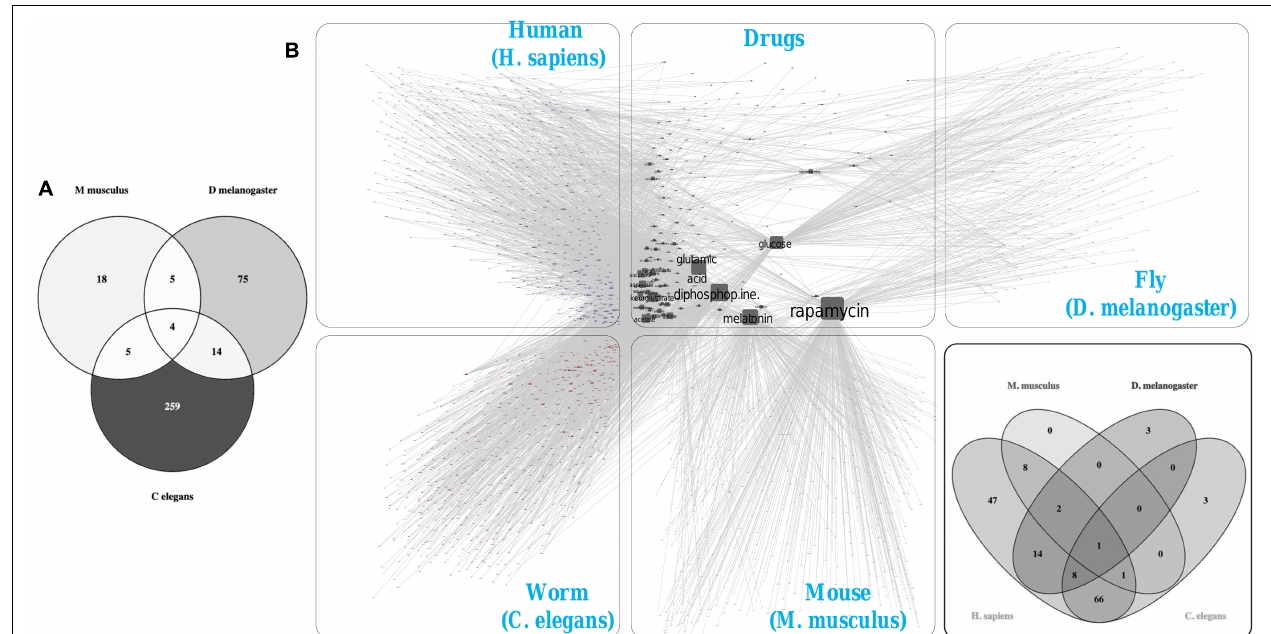
FIGURE 7 | Cross-species longevity drug targets mapping. (A) Compilation the drugs, compounds and supplements (including natural products and nutraceuticals) with anti-aging properties that extend longevity in three model organisms (mice, flies, and worms) from DrugAge database. (B) The species-specific drug targets mapping for 380 identified drugs in human, mice, flies and worms using available drug-protein interaction information from STITCH database. The Venn diagram shows the overlapping of drugs based on shared targets within all four studied species.